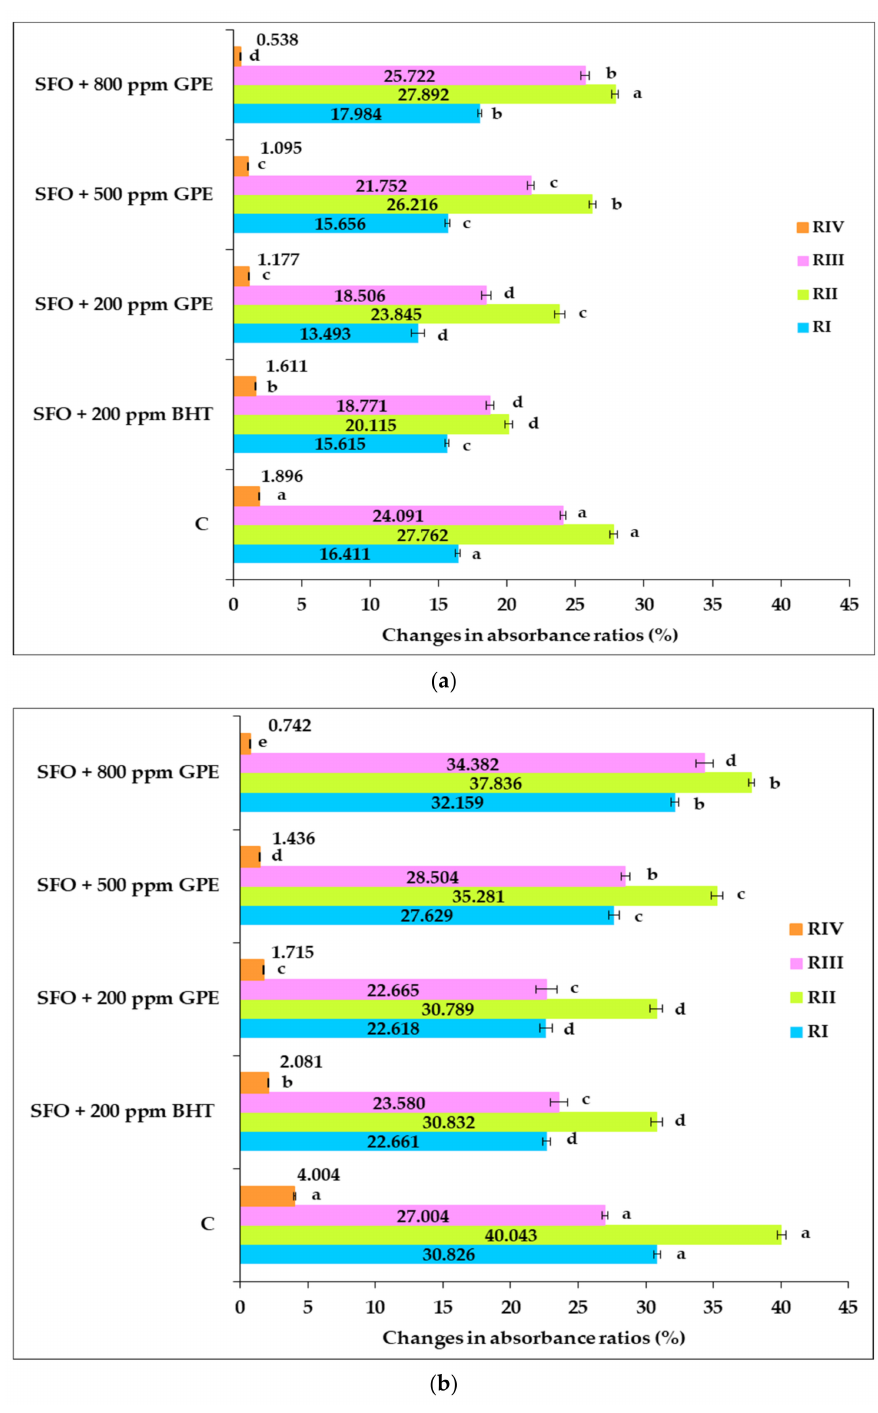
Figure 6. The percentage changes in the absorbance ratios of heat-treated oil samples compared to the corresponding untreated samples: ( a ) after 4 h and ( b ) after 8 h. A 3009 cm − 1 /A 2922 cm − 1 (RI), A 3009 cm − 1 /A 2853 cm − 1 (RII), A 3009 cm − 1 /A 1744 cm − 1 (RIII) and RIV = A 1744 cm − 1 /A 2922 cm − 1 (RIV). The values for bars with different letters are significantly different from each other (one-way ANOVA, p <